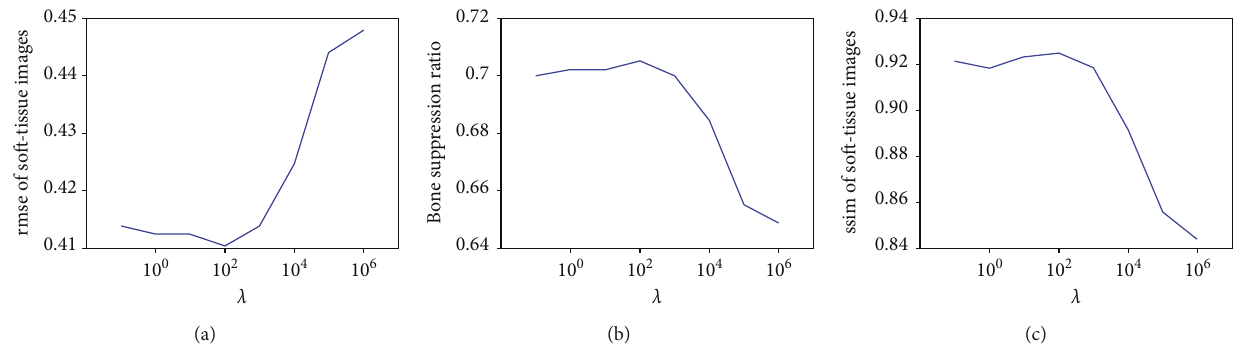
Figure 4: The e ff ect on decomposition performance of parameter λ (weight of the data term).